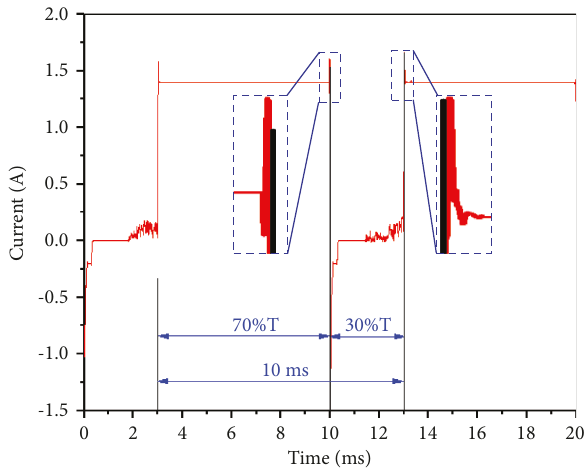
Figure 15: Current response